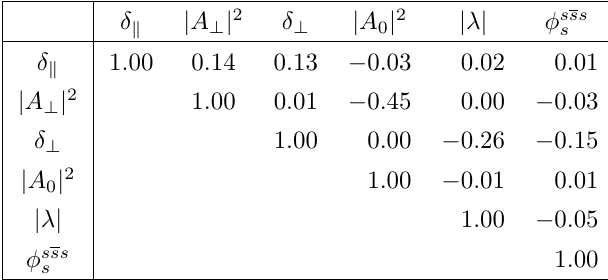
Table 8 . Statistical correlation matrix of the time-dependent (cid:12)t.